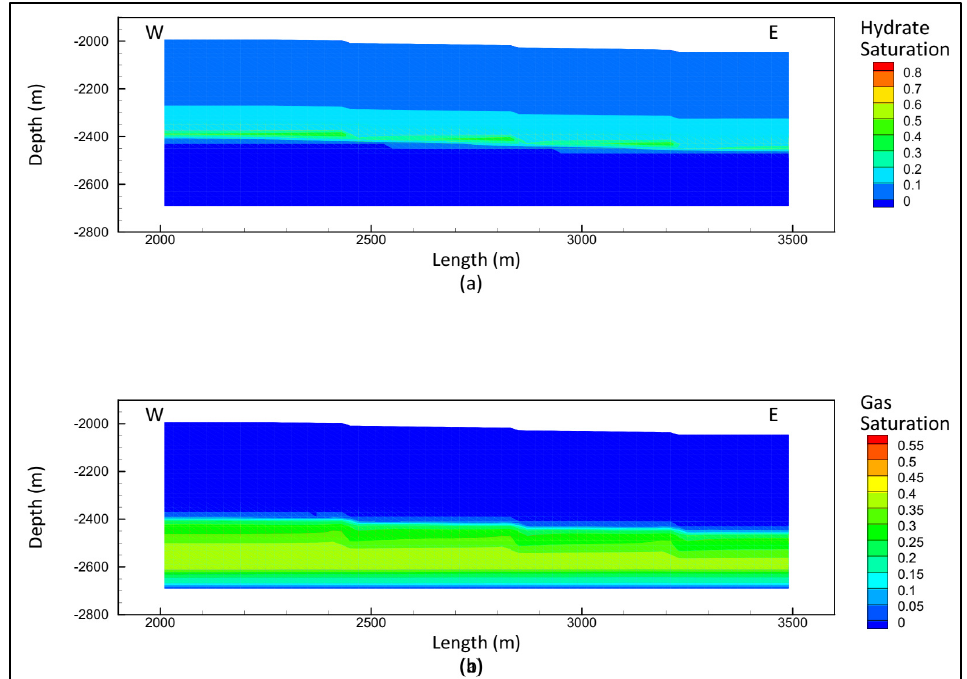
Figure 3. Hydrate formation after 100 thousand years, assuming slow upward migration due to buoyancy. ( a ) The hydrate saturation reaches a maximum of 55% and is uniformly distributed along the length of the reservoir model. ( b ) The underlying gas layer is typical in hydrate reservoirs at Green Canyon.